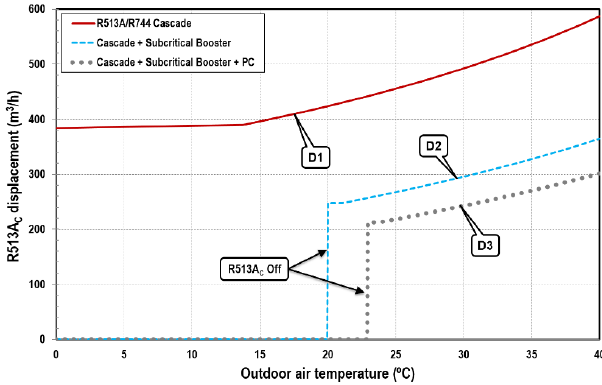
Figure 15. R513A compressor displacement.